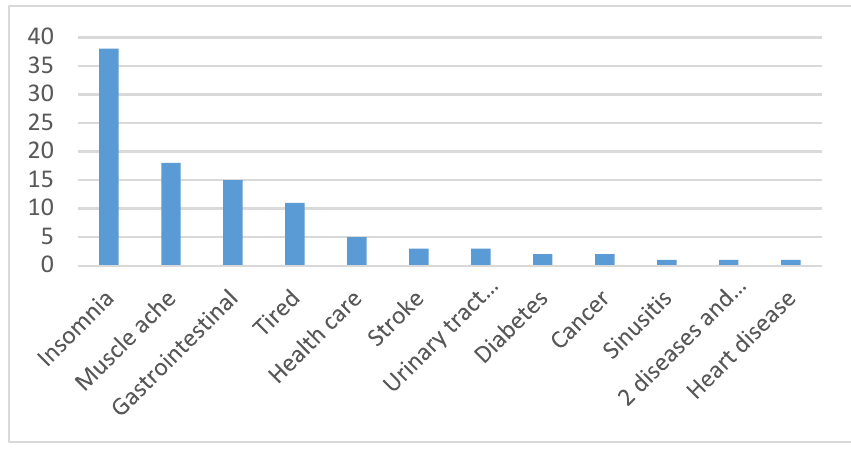
Figure 3. The most common cases of foot therapy in practice.